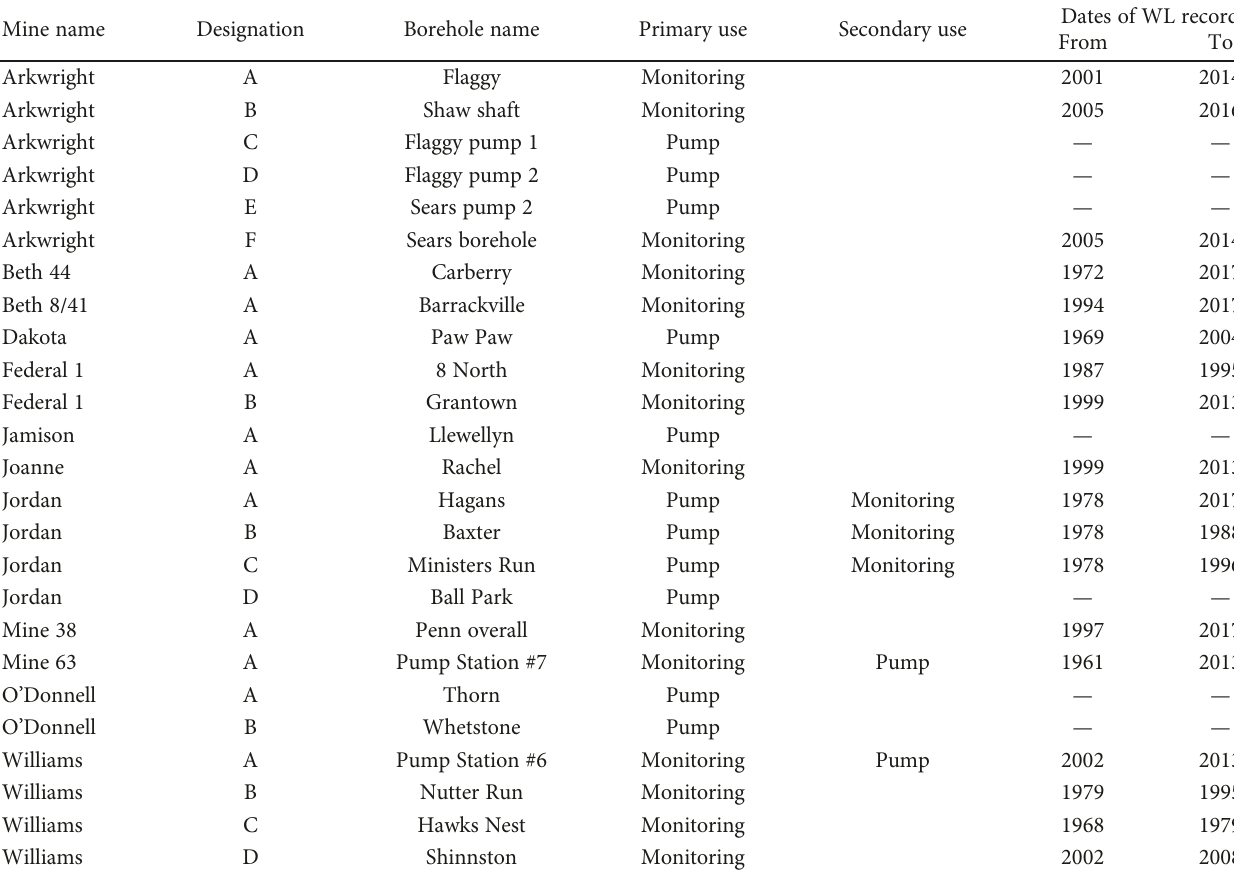
Table 2: Monitoring and pumping wells in the study area. See Figure 4 for